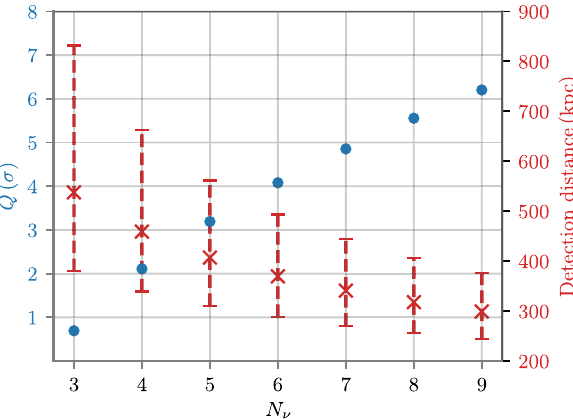
Fig. 9 Detection prospects for a CCSN whose time is known to within 1 h ( m ≥ 7, Δ t coin = 20ns, Δ T SN = 10s). Left axis: probability that the signal is not produced by background fluctuations. Right axis: distance at which a 27M (cid:2) progenitor mass CCSN is detected with 10% (upper boundary), 50% (middle mark) and 90% probability (lower boundary), when at least N ν detected events are required √ Z = 2 (( s + b ) ln ( 1 + s / b − s ) . Here, s is the